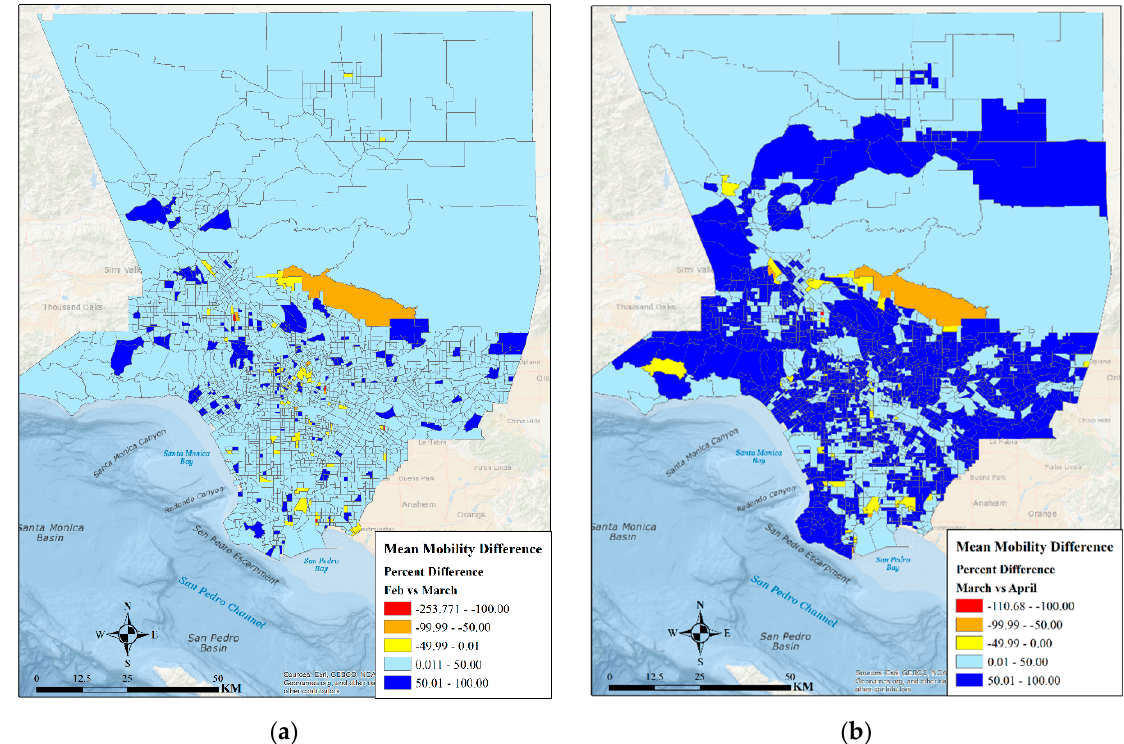
Figure 6. Mean mobility percentage difference in LA between February and March ( a ) and between March and April ( b ).